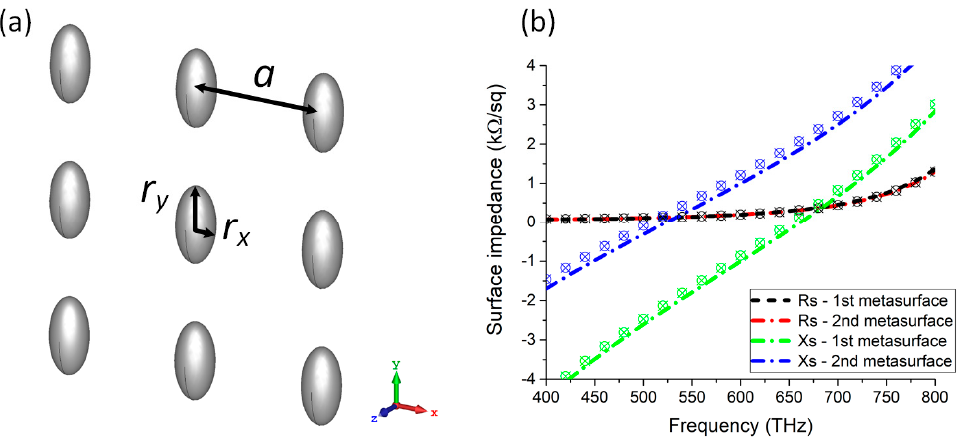
Figure 2. ( a ) The optical metasurface made by an array of ellipsoidal plasmonic nanoparticles arranged in a square lattice; ( b ) the complex surface impedance of two different optical metasurfaces designed to have the same surface resistance ( R s = 200 Ω ) and opposite reactive behaviors (capacitive and inductive). The ticks represent the results of full-wave simulations.